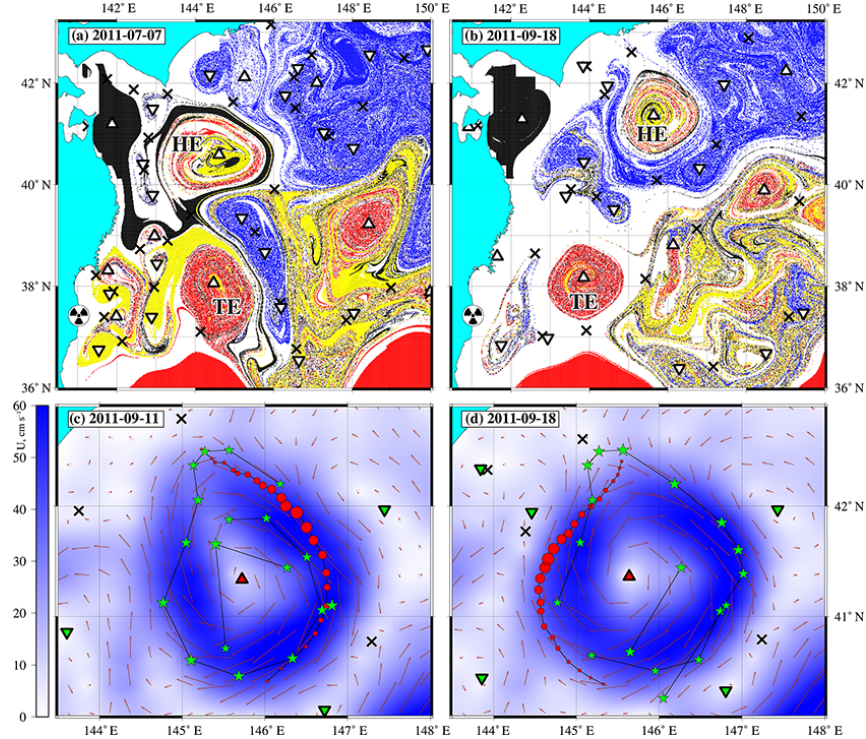
Figure 3. (a) – (b) The Lagrangian maps show evolution of the Hokkaido eddy (HE) after the FNPP accident to the days of its sampling and the origin of waters in its core and at the periphery. (c) – (d) A fragment of the track of the drifter no. 39123 is indicated by the full circles for 3 days before the day indicated with the size of circles increasing in time. Tracks of three Argo floats are shown by the stars. The largest star corresponds to the day indicated and the other ones each show float positions 7 days before and after that